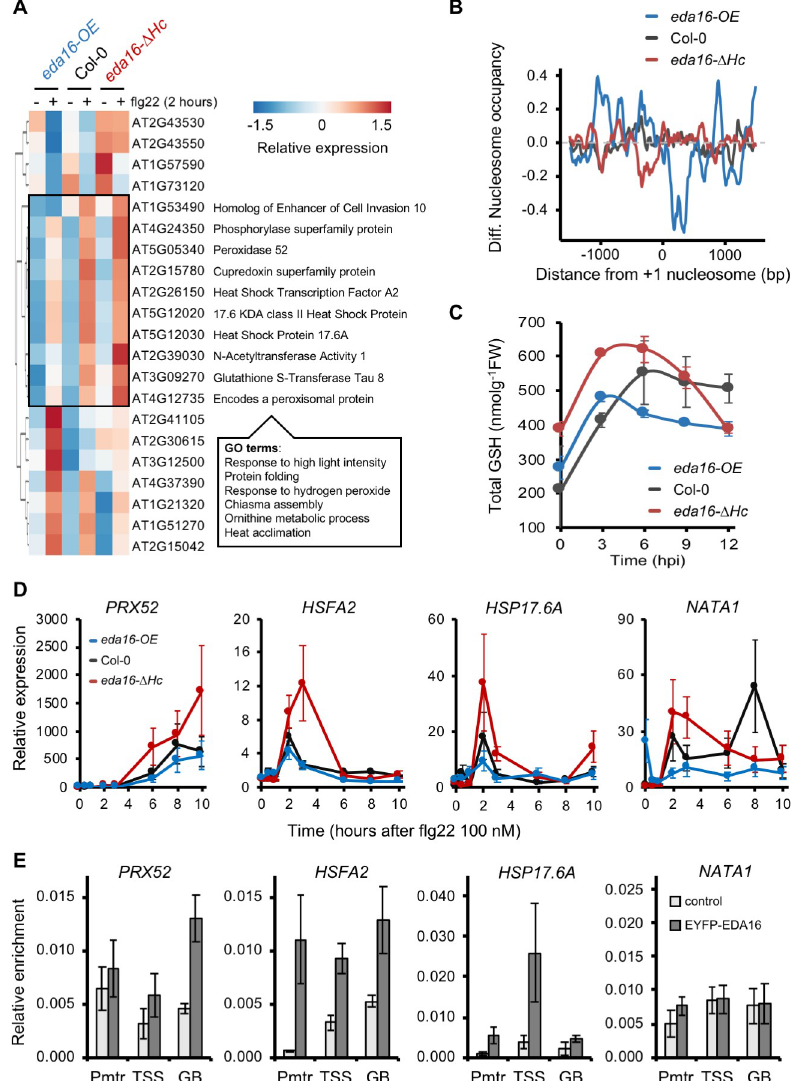
Fig 5. EDA16 regulates plant redox homeostasis during immune responses. (A) EDA16 affects the expression of a subset of flg22-regulated genes. Heatmap of Differentially Expressed Genes between Col-0, eda16-OE and eda16- Δ Hc plants 2h after elicitation with 100 nM flg22. The box on the heatmap indicates genes with a distinct pattern of misregulation in the eda16-OE and eda16- Δ Hc mutant plants and accompanied with their (TAIR10) gene description. Most significant GO terms found for the intersection group. (B) Differential nucleosome occupancy of the 21 EDA16 - flg22 DEGs. Differences between the average nucleosome occupancy of EDA16 -regulated flg22-induced genes in Col-0 (grey), eda16-OE (blue), and eda16- Δ Hc (red) 2 hours after elicitation with 100 nM flg22 and mock. The graph is centered on the +1 nucleosome from the gene TSS. (C) The EDA16 mutation alters glutathione concentration. Total glutathione (GSH) levels as concentration per fresh weight were measured in 3-week-old Col-0 (black), eda16-OE (blue) and eda16- Δ Hc (red) plants at the indicated times following infection with Pst DC3000. Error bars represent standard deviation, n = 3. (D) EDA16 negatively regulate the expression of target genes. Gene expression of PRX52 , HSFA , HSP17 . 6A and NATA1 assessed by qPCR in 2-week-old Col-0 (black) eda16-OE (blue) and eda16- Δ Hc (red) seedlings elicited with 100 nM flg22. Values are average of three biological repeats ± SE presented as fold induction compared with Col-0 mock-treated sample at time 0. (E) EDA16 directly binds on target genes. ChIP-qPCR was performed on leaves from Col-0 and Col-0 35S :: EDA16-YFP 5-week-old plants (n = 20) to assess EDA16 binding to PRX52 , HSFA , HSP17 . 6A and NATA1 . Three primer pairs were used for each gene corresponding to promoter region (Pmtr), TSS and gene body (GB). Values are average of three biological repeats ± SEM presented as relative enrichment compare to